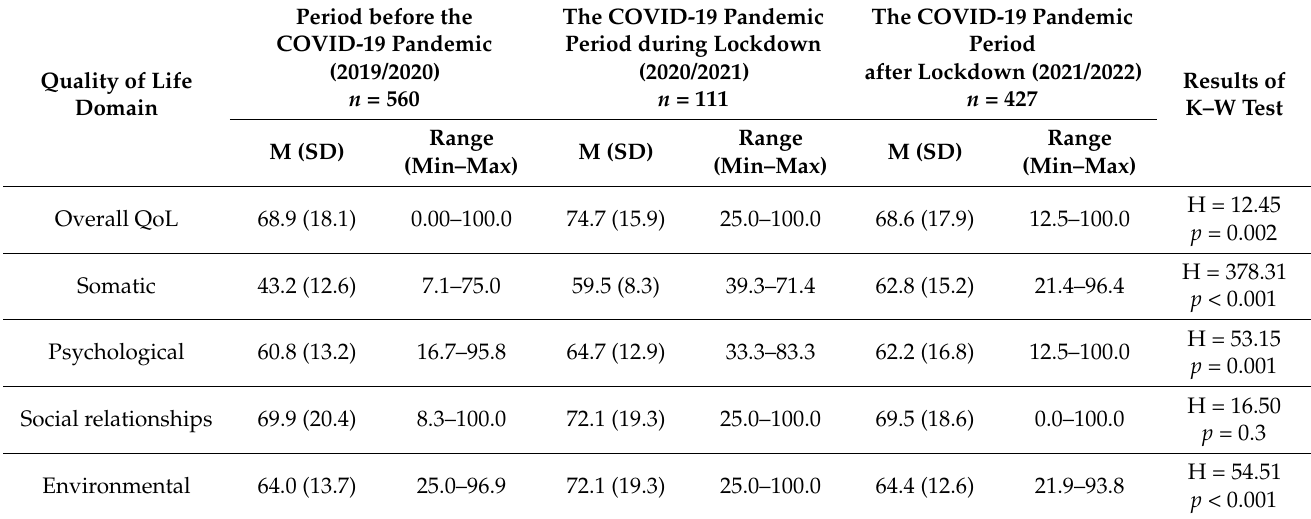
Table 2. Summary of the WHQOL-BREF domains (scoring after transformation).